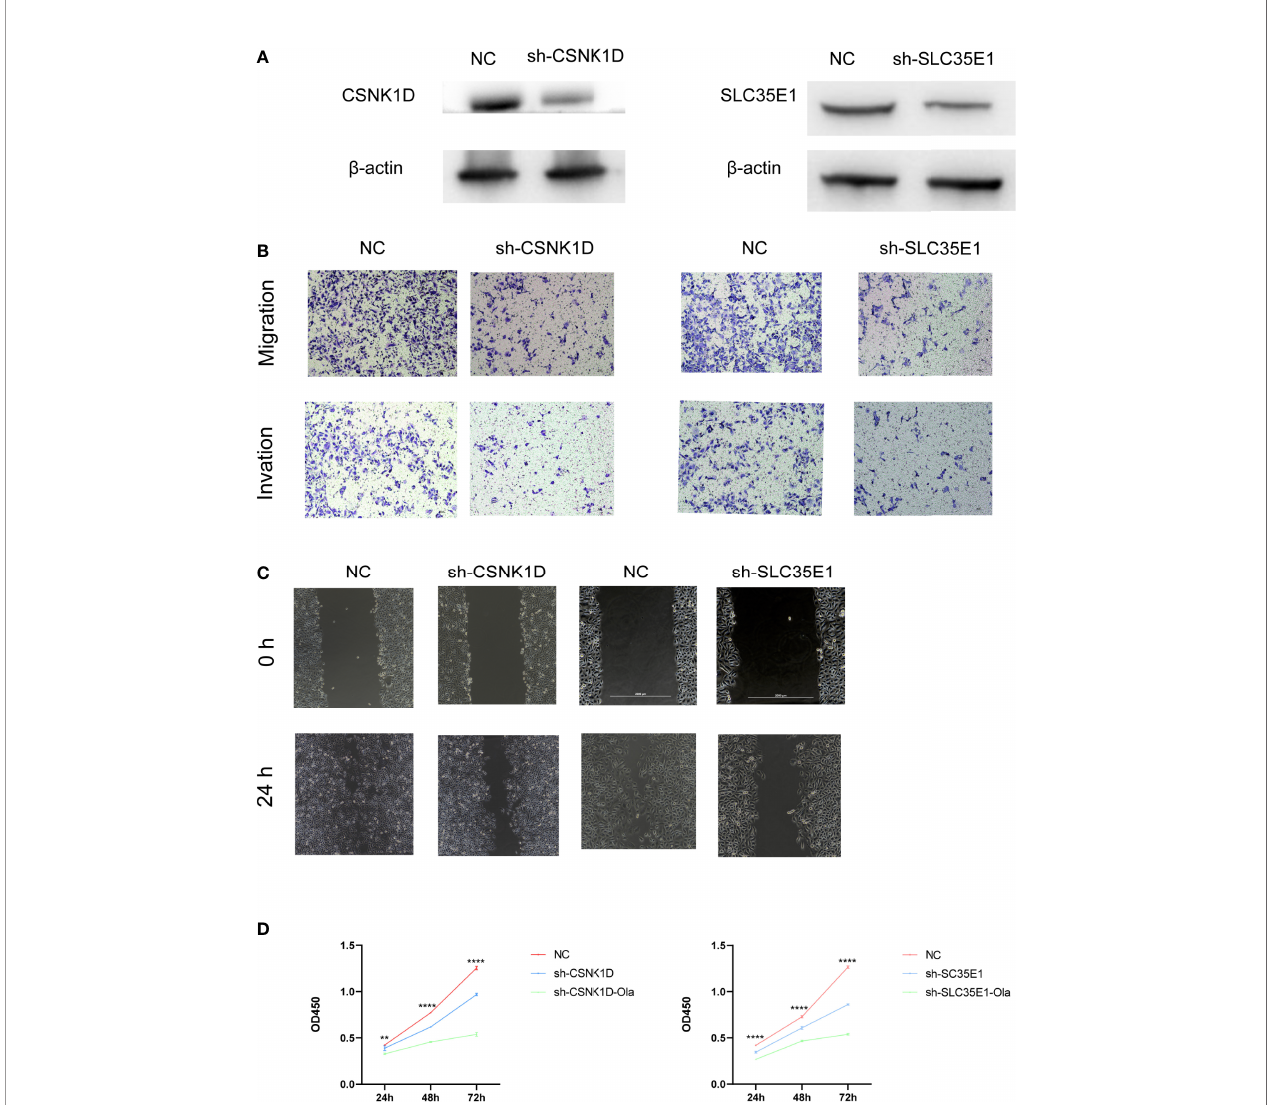
FIGURE 6 | CSNK1D or SLC35E1 ablation promotes PC3 cell metastasis and proliferation in vitro . (A) Western blot analysis of CSNK1D or SLC35E1 expression levels in CSNK1D or SLC35E1 knockdown cells and vehicle control cells. (B) Representative images of migration (upper panels) and invasion (lower panels) assays using PC3 cells, presenting cell migration and invasion after knockdown of CSNK1D or SLC35E1. (C) Wound healing assays using PC3 cells presenting cell motility after knockdown of CSNK1D or SLC35E1 ablation. (D) Cell proliferation was evaluated in CSNK1D (left) or SLC35E1 (right) ablated PC3 cells with or without olaparib administration. **P ≤ 0.01, ****P ≤